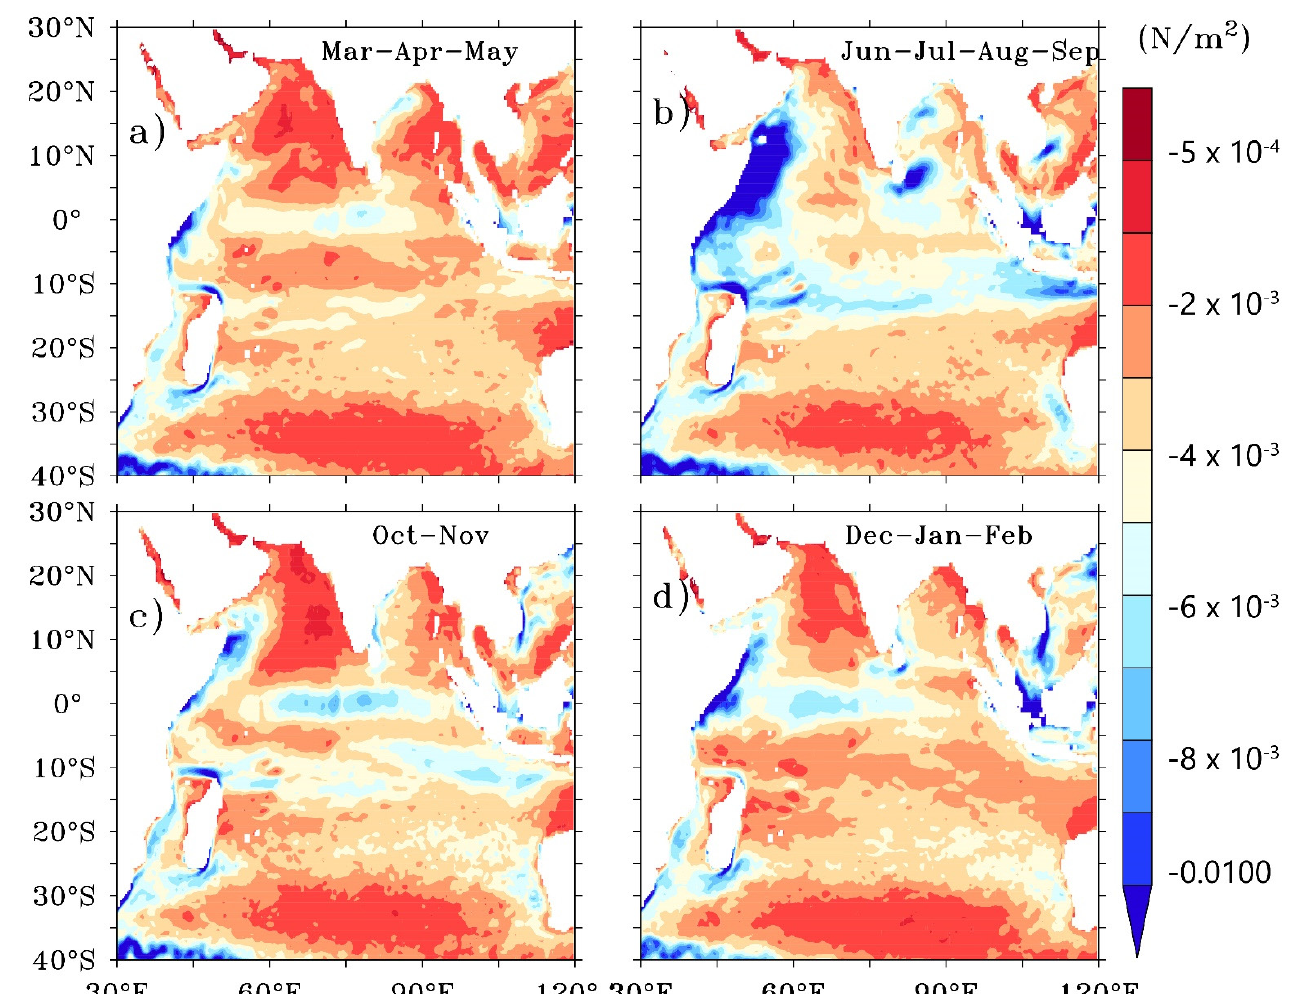
Figure 4. Seasonal and spatial distribution of the difference between the two wind stress estimations ( τ Cur − τ no-Cur ) averaged over 2007–2020. ( a ) Spring season (March-May), ( b ) Summer monsoon season (June-Sepetember), ( c ) Autumn season (October-November), ( d ) Winter monsoon season (Decem- ber-February).